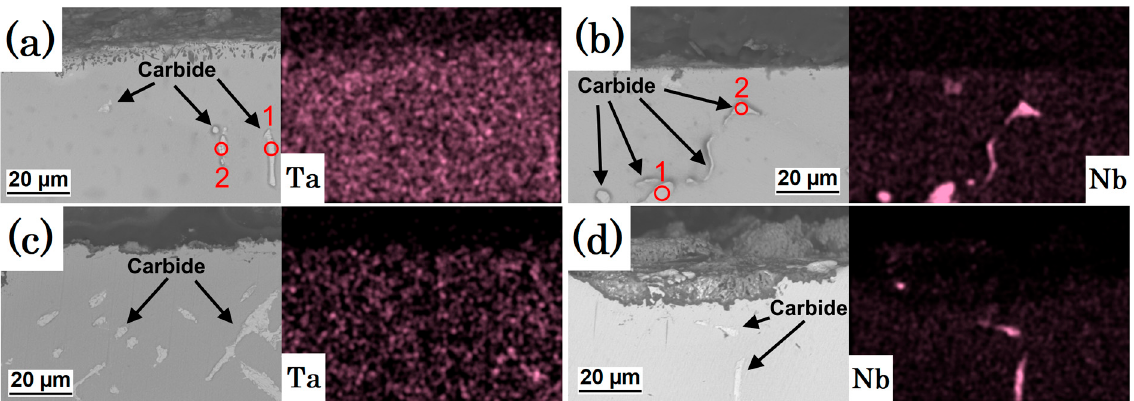
Figure 9. SEM and EDS mapping for 120 cycles. ( a ) MAR-M246(Ta) at 900 °C, ( b ) MAR-M246(Nb) at 900 °C, ( c ) MAR-M246(Ta) at 1000 °C, and ( d ) MAR-M246(Nb) at 1000 °C.